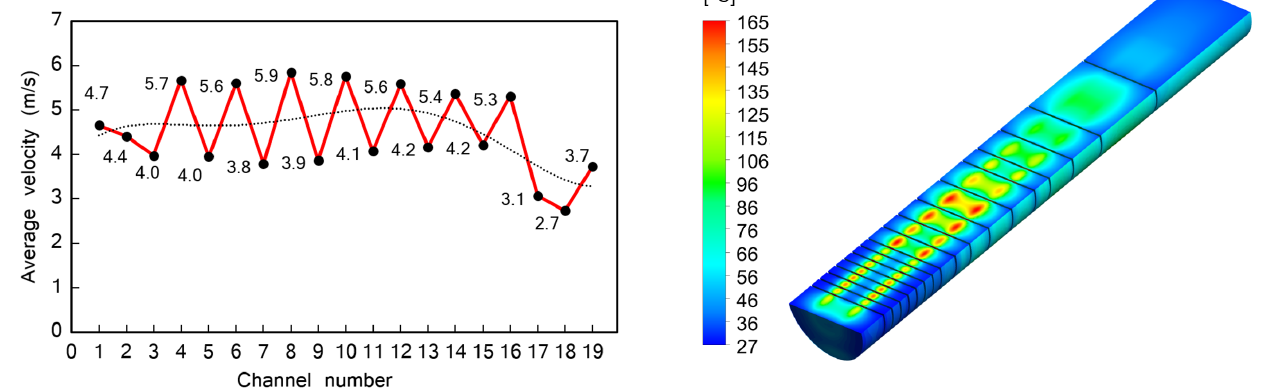
FIG. 11. Half-model temperature distribution in the target blocks at the end of the proton pulse (1 second) during steady state conditions, with the HTC evaluated from CFD simulations. The maximum temperature expected is around 160 °C, found in blocks 9 and